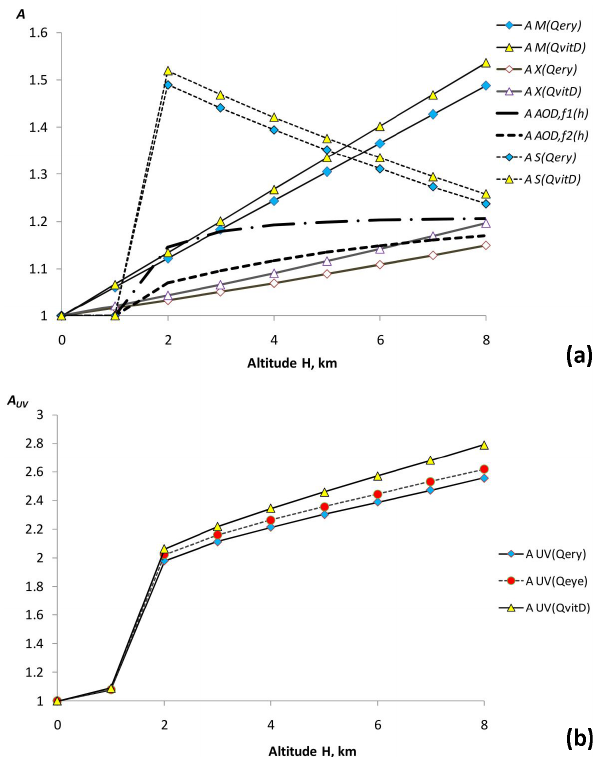
Figure 10. The UV amplification due to molecular A M (Q ery ) , A M (Q vitD ) , ozone A X (Q vitD ) , A X (Q ery ) , aerosol A AOD ,f 1 (H) , A AOD f 2 (H) for the Alpine f 1 (H) and Asian f 2 (H) types of altitude dependences, and surface albedo A S (Q ery ) , A S (Q vitD ) changes with the altitude (a) and their total altitude effect on A UV for different types of BAUVR (b) . At H = 0km: AOD 340 = 0 . 8, X = 250DU. The surface albedo has an abrupt change at 2km from S = 0 to S = 0 . 95. Solar elevation – h = 50 ◦